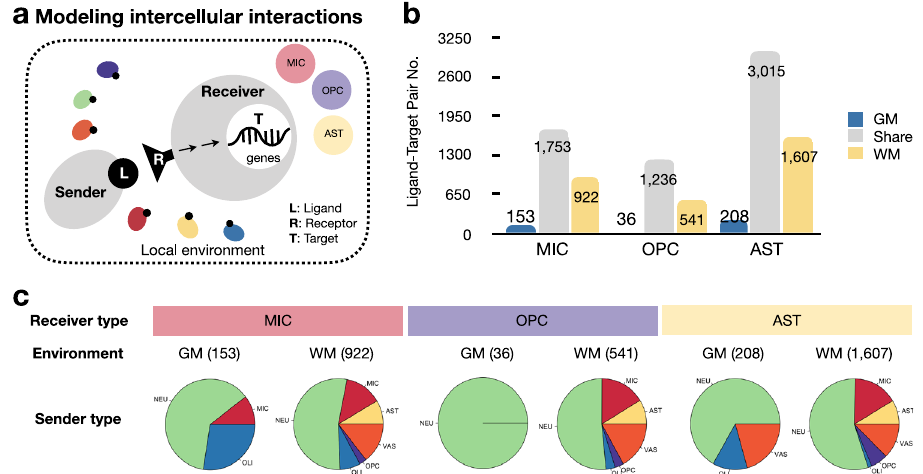
Fig.8|WMandGMresidentcellsdivergeinintercellularactivity.a Intercellular communication in WM and GM microenvironments were modeled with NicheNet. b Barplotshowingthenumberofestablishedligand-targetpaintsthatwereunique